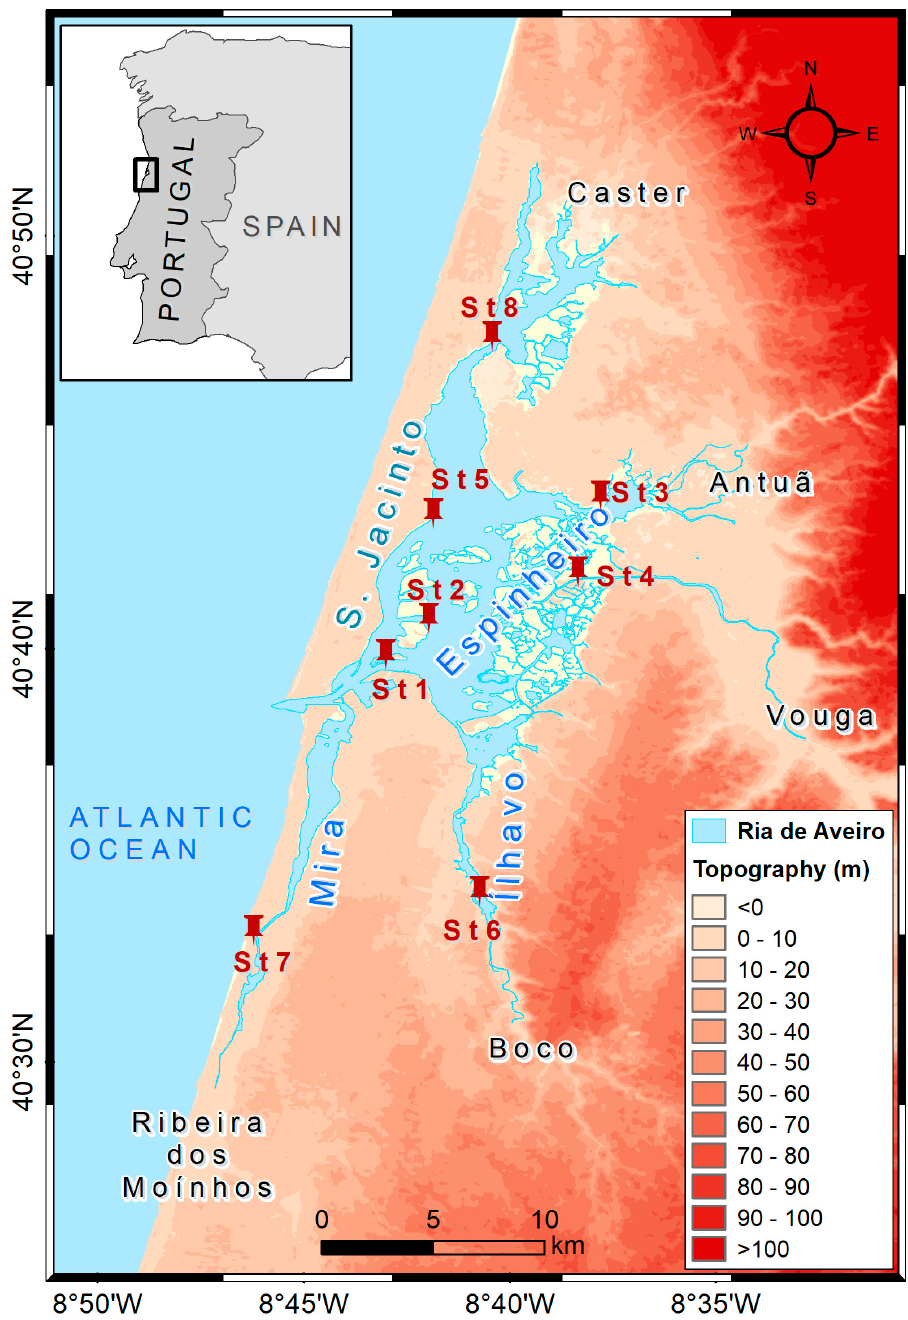
Figure 1. The study area: the Ria de Aveiro lagoon, with the location of the stations (St1 to St7). The lagoon is a shallow water and well-mixed system, except near the lagoon mouth, where some stratifications are observed, resulting from the water confluence of the ocean saltwater and mix-water from the Espinheiro channel, which is connected to the Vouga river [44,45]. The tide is semidiurnal inducing sea level variations at the lagoon mouth between 0.45 m and 3.80 m. Dias [45], Vaz and Dias [46], Dias et al. [47–49], and Dias and Lopes [50] characterised the lagoon in two main areas: (1) the central area under the influence of the tide, characterised by strong currents, along the S. Jacinto and the Espinheiro channels, particularly close to the lagoon mouth where the intensity of the currents may reach values higher than 2 m s − 1 , which progressively decrease toward the inner areas of the channels, (2) the far end channels, which are mainly very shallow intertidal areas, where the